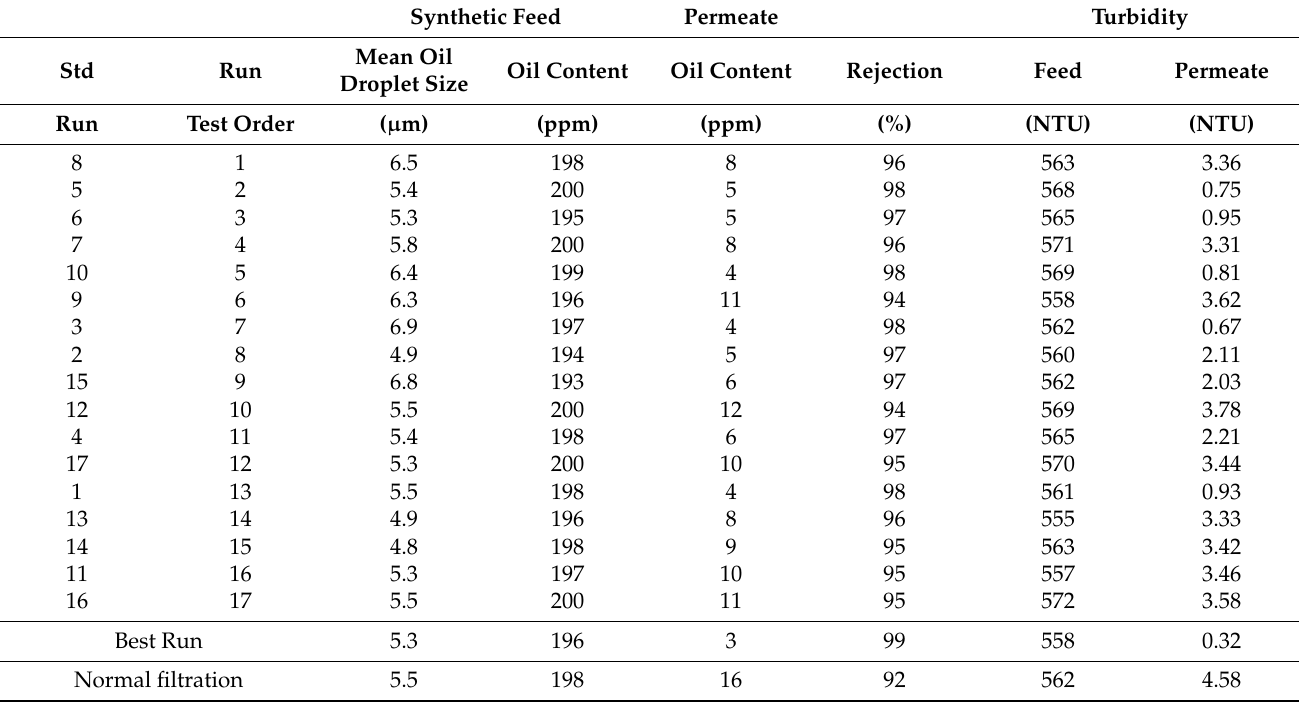
Table 8. Feed and permeate